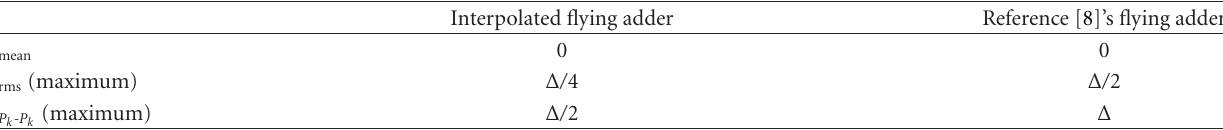
Table 1: Jitter performance comparison.